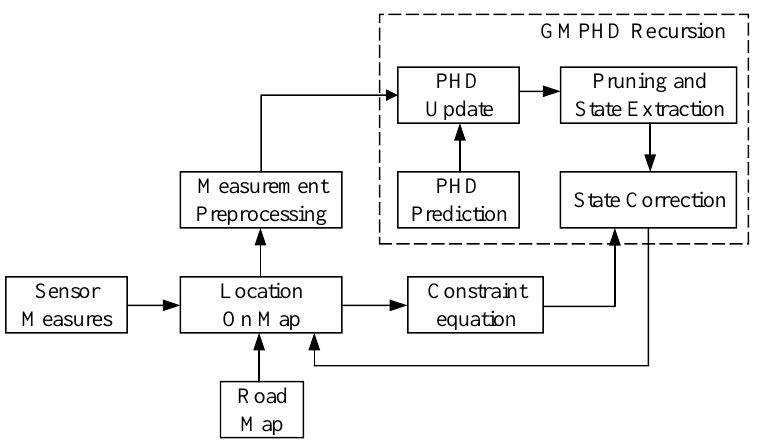
Figure 2. Framework of the state constraint (SC)-GMPHD filter.